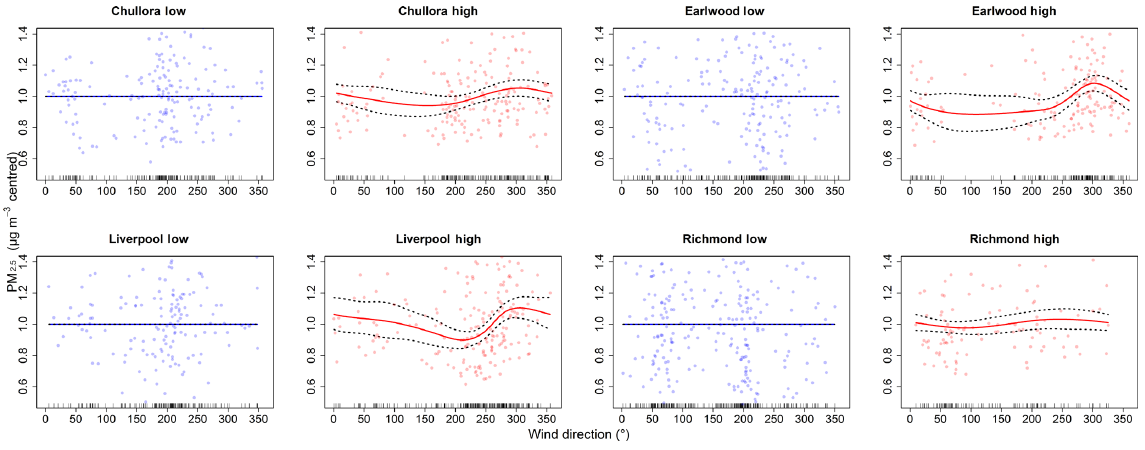
Figure 9. The contribution by the wind direction component of the GAMM linear predictor to fitted PM 2 . 5 values (µgm − 3 ,